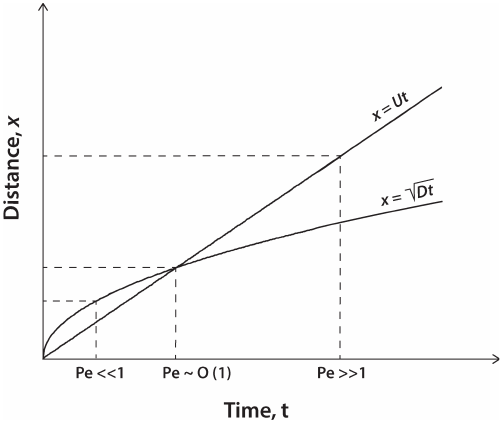
Fig. 1. The relationship between characteristic length, x , and time, t , scales under varying Peclet number conditions. Under Pe (cid:29) 1, advective processes dominate (Regime I); under Pe (cid:28) 1 diffusive processes dominate (Regime II); when Pe ∼ O(1), the characteristic length and timescales are set where the advection and diffusive lines